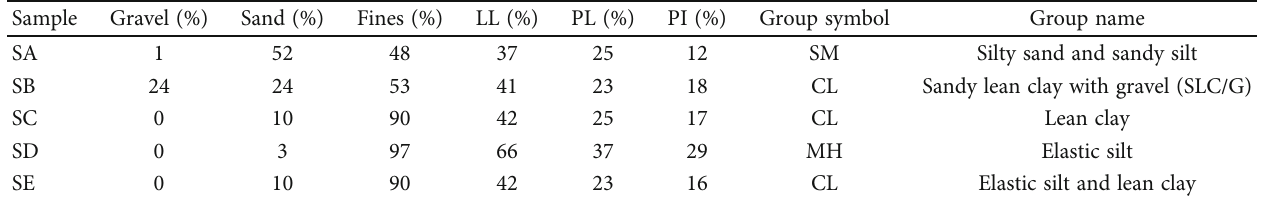
Table 3: Soil particle size and classi fi cation.